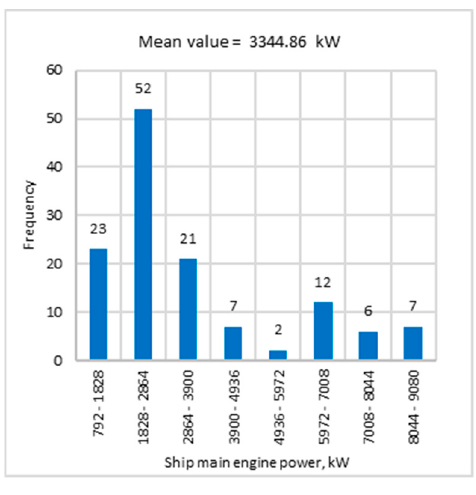
Figure 2. Ship length ( left ) and GT ( right ).